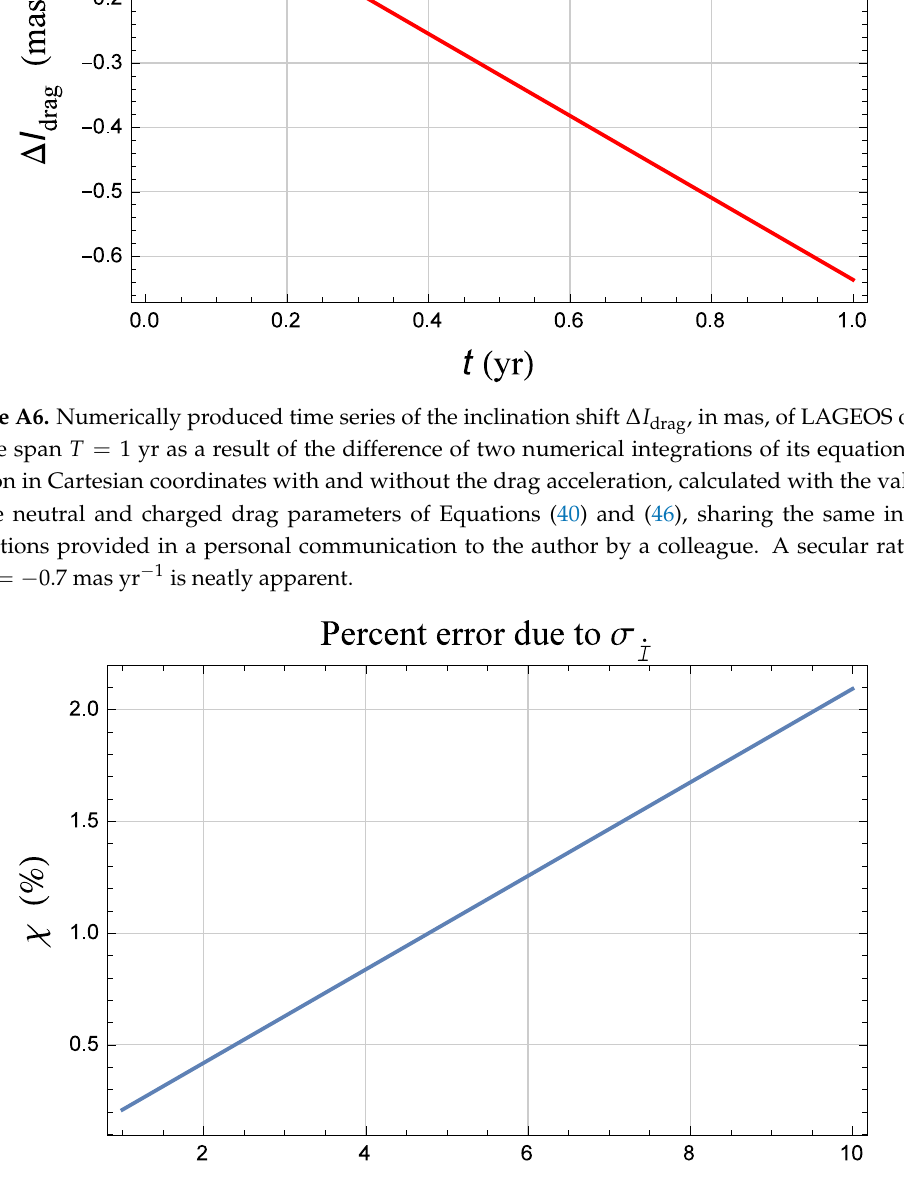
= 0.03 mas yr − 1 . By I L/CL